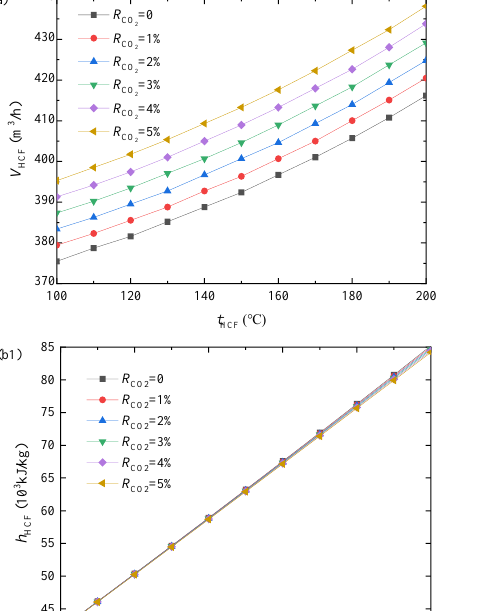
Figure 7. Variation curves of production capacity parameters of heat carrier with t HCF under different qualities: ( a ) volume flow rate, ( b ) enthalpy and ( c ) absolute enthalpy difference.